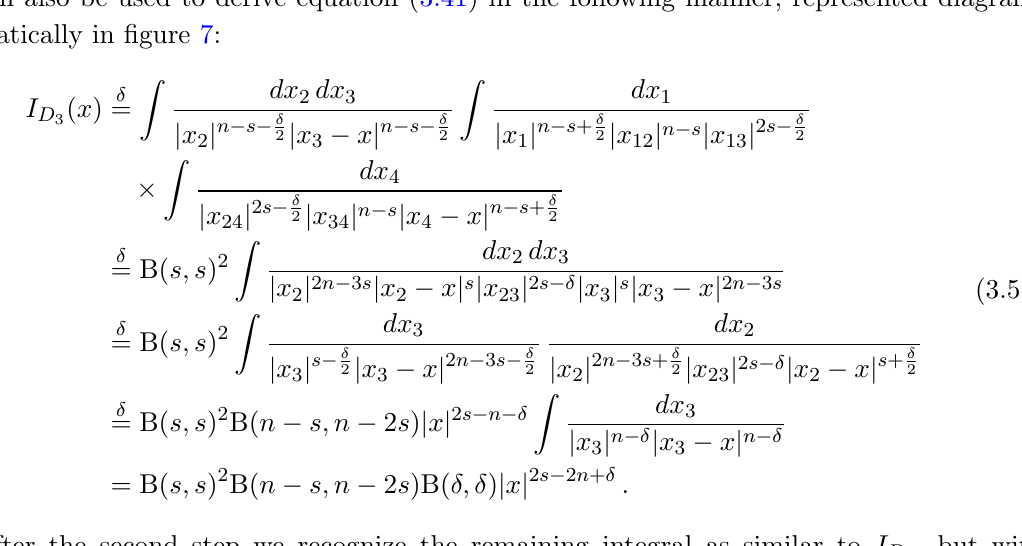
Figure 6 . The symmetric deformation of I D that allows the integral to be exactly evaluated 2 without disturbing the leading behavior in (cid:14) . (cid:17) is eventually set to (cid:14)= 2. This method of (cid:12)nding the leading order behavior of a Feynman diagram by symmetri- cally changing the scaling of internal propagators and invoking equations (3.49) and